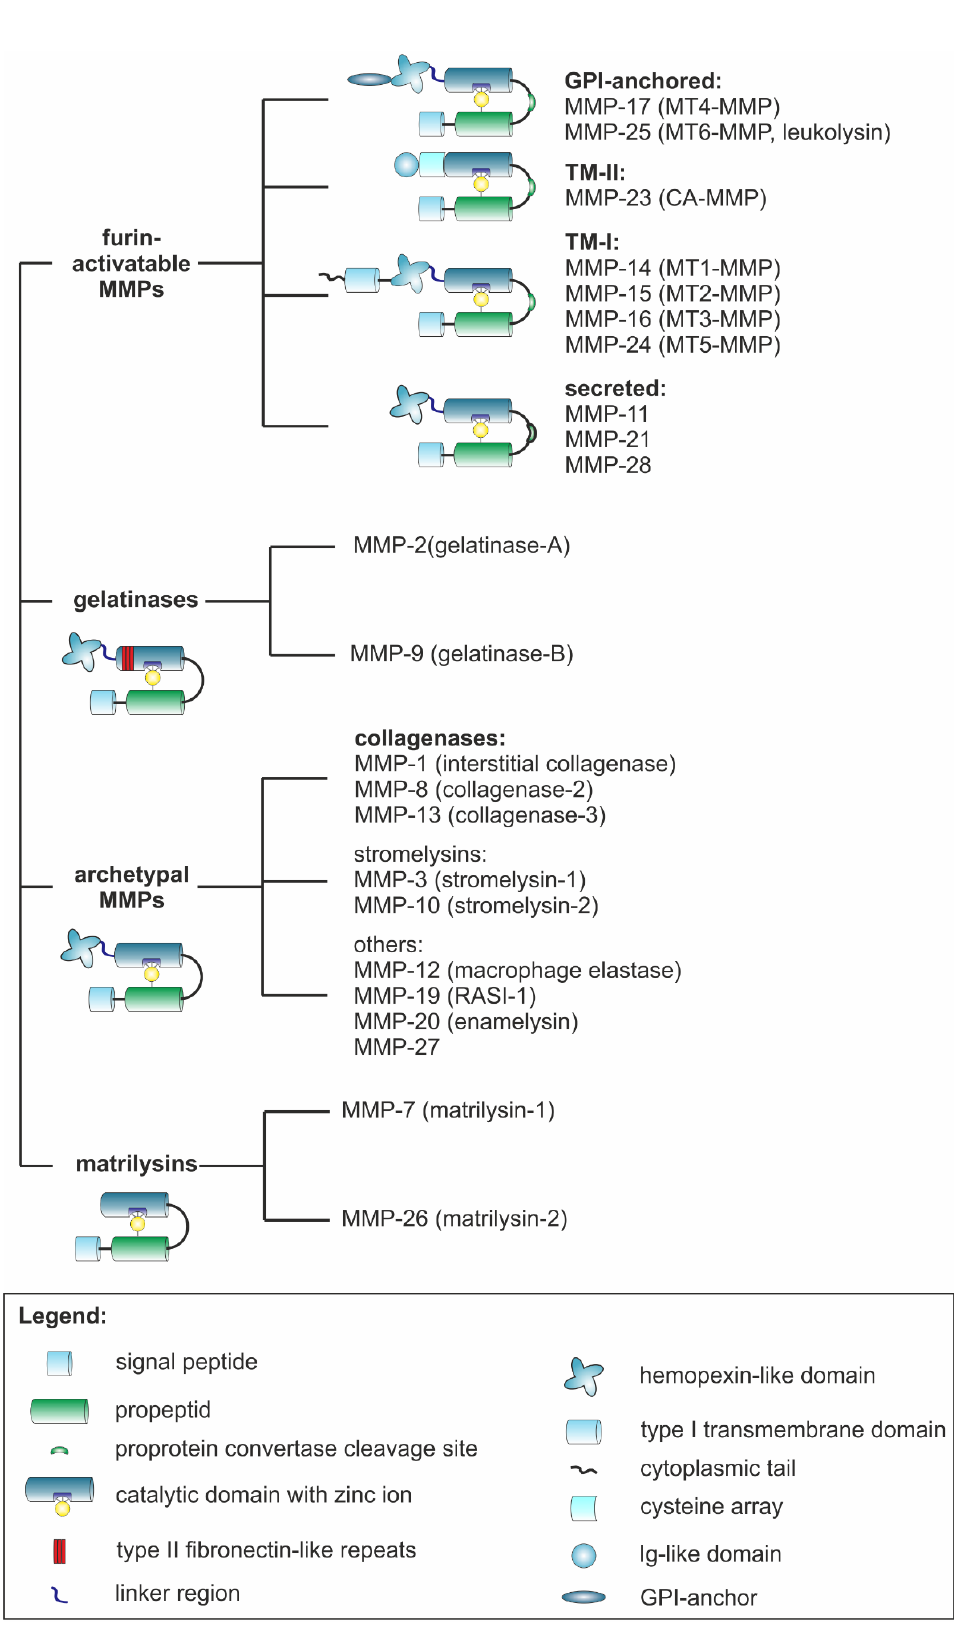
Figure 2. Structural and functional diversity of matrix-metalloproteinases. The 23 human MMPs are assigned to different groups according to their domain structure and substrate specificity. Most of them, except for MMPs -20, -23, and -27, are involved in processes that shape the TME [12,74–76].